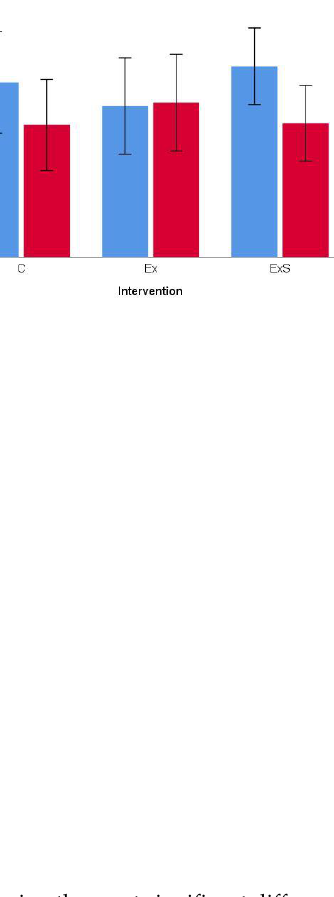
Figure 1. Gene expression levels of three genes ( PRKCQ , ANXA6 , and BIN1 ) showing the most significant difference before and after interventions. C: control; Ex: exercise; ExS: exercise and nutrient supplement; The gene expression shown is relative gene expression to geometric mean of 3 house-keeping genes; p < 0.05. Table 3. Linear regression analysis showing the interaction of intervention and gene expression in modulating the leg extension Table 2. Table showing genes with significant changes in gene expression before and after combined exercise and nutrient supplement intervention.